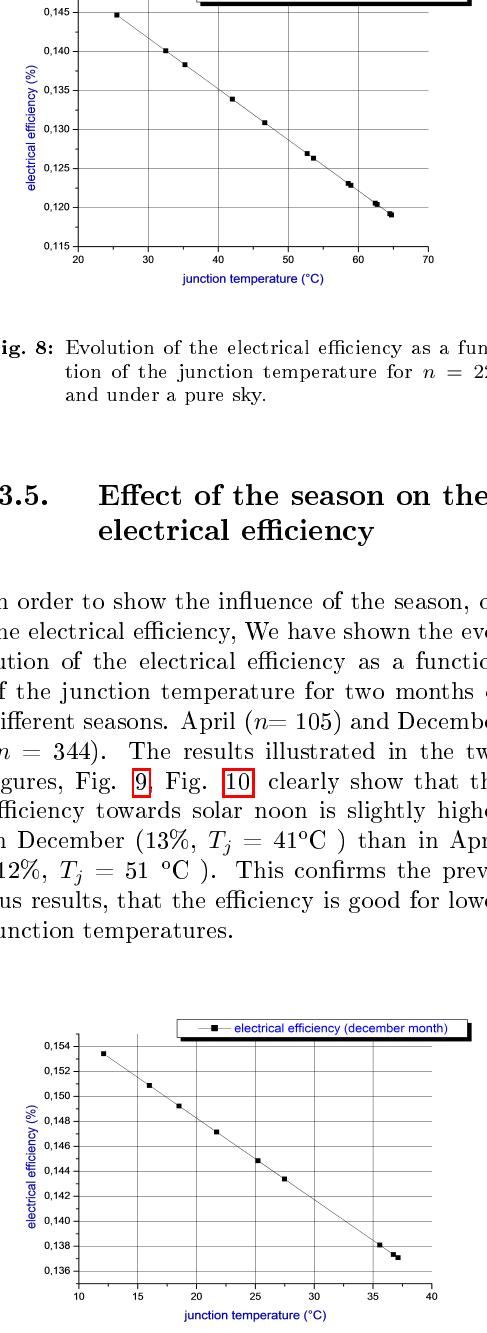
Fig. 9: Evolution of electrical e(cid:30)ciency as a function of the junction temperature for n = 344 under a degraded sky.